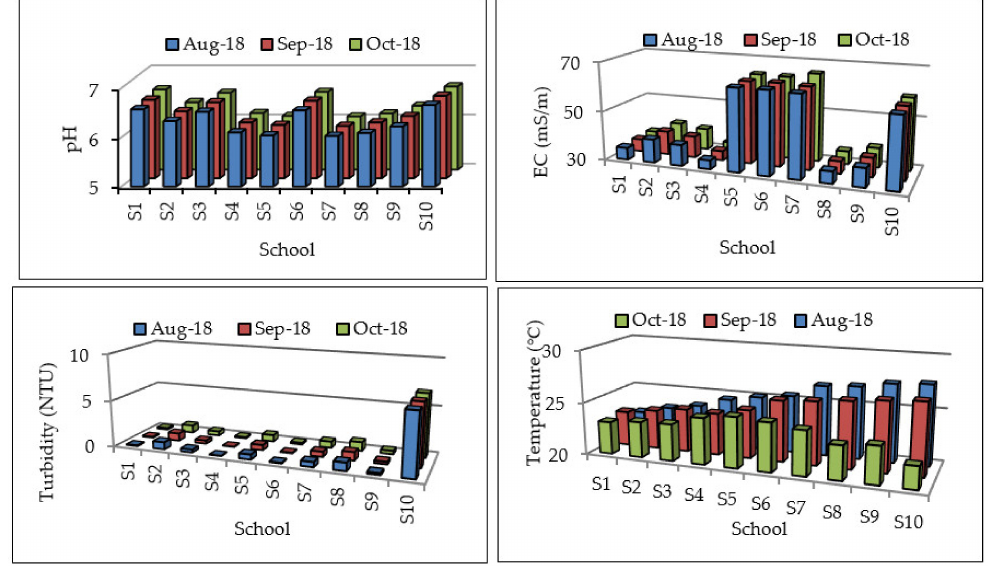
Figure 2. Physical parameters in groundwater samples.